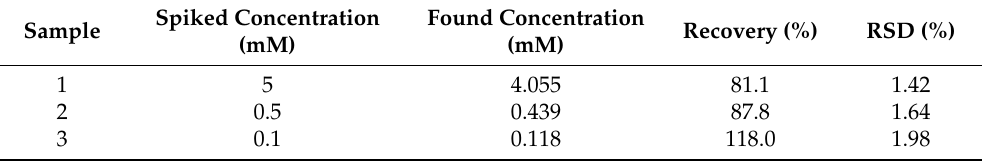
Table 3. Detection performance for glucose in healthy human blood